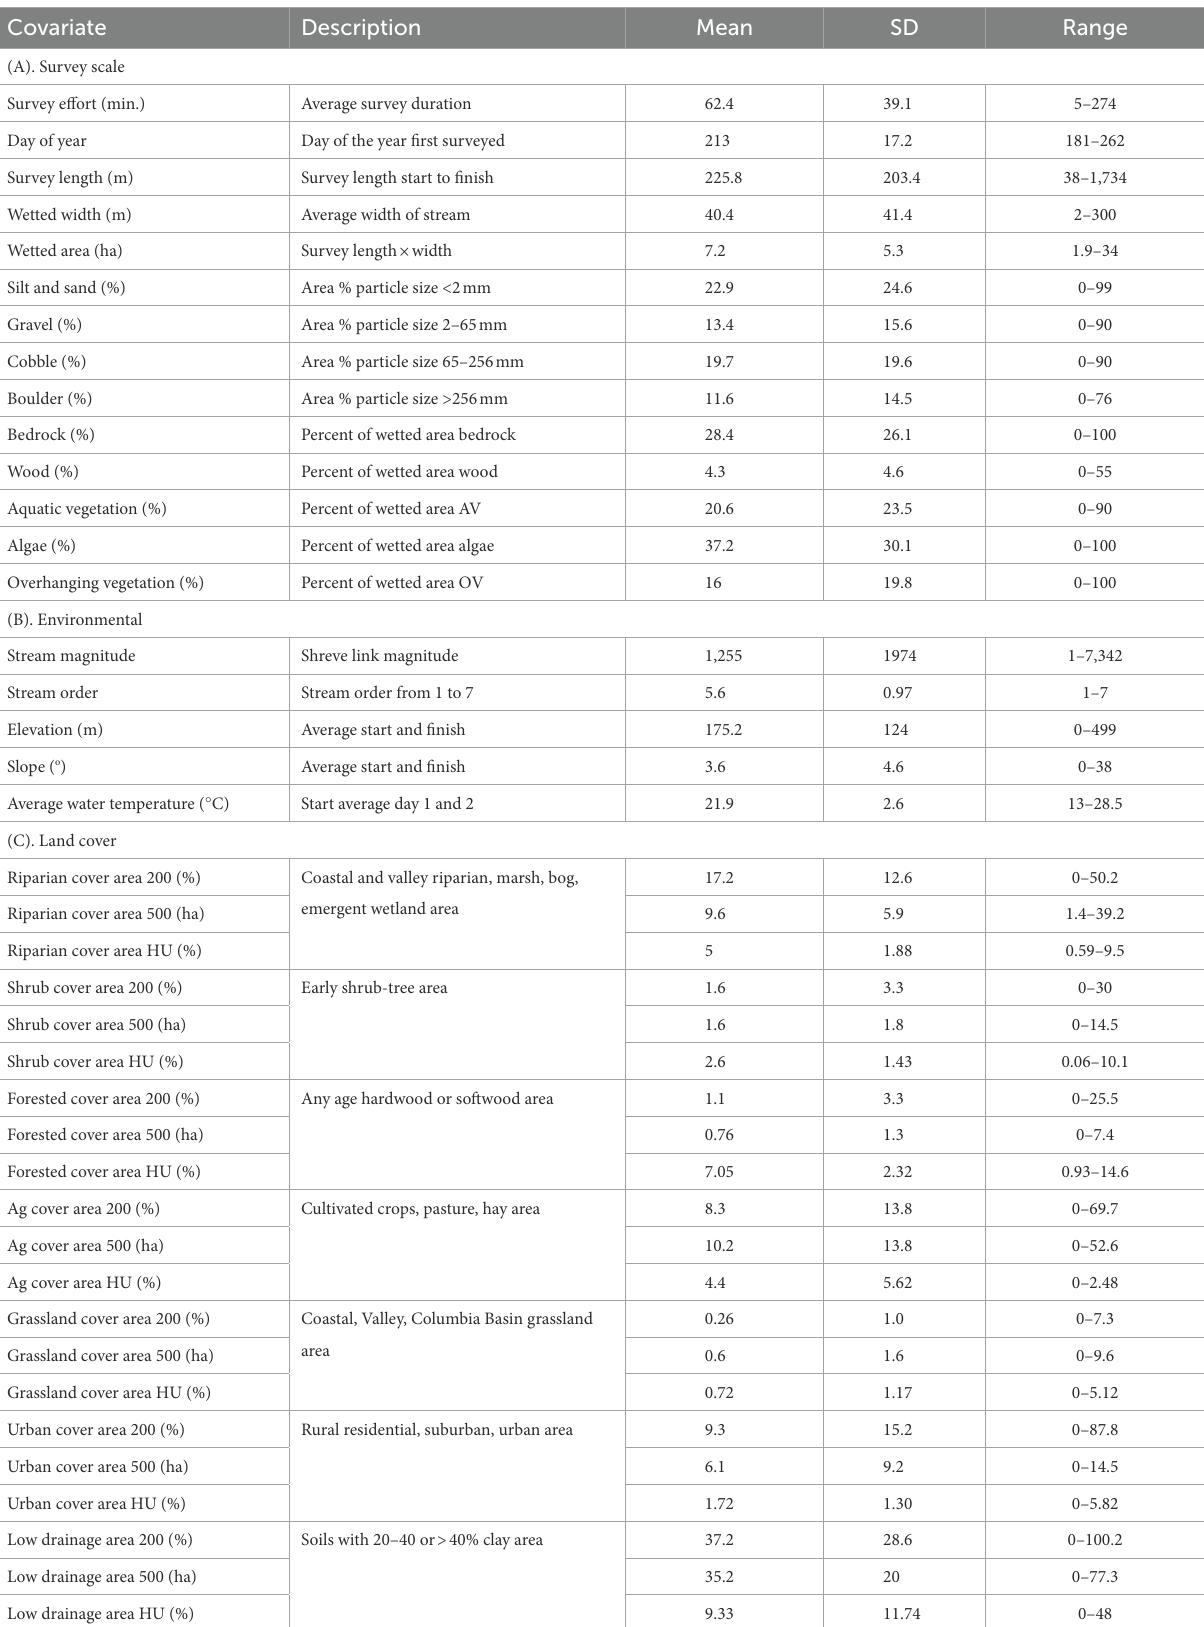
TABLE 2 Descriptions and summaries of (A) survey scale, (B) environmental, and (C) land cover covariates extracted from three buffer sizes; (1) 200 m width, variable area, (2) 500 m radius circular 78.5 ha, and (3) hydrological unit (HU12) watersheds for 304 snorkel surveys during 2006–2021 within the Umpqua basin, Oregon, United